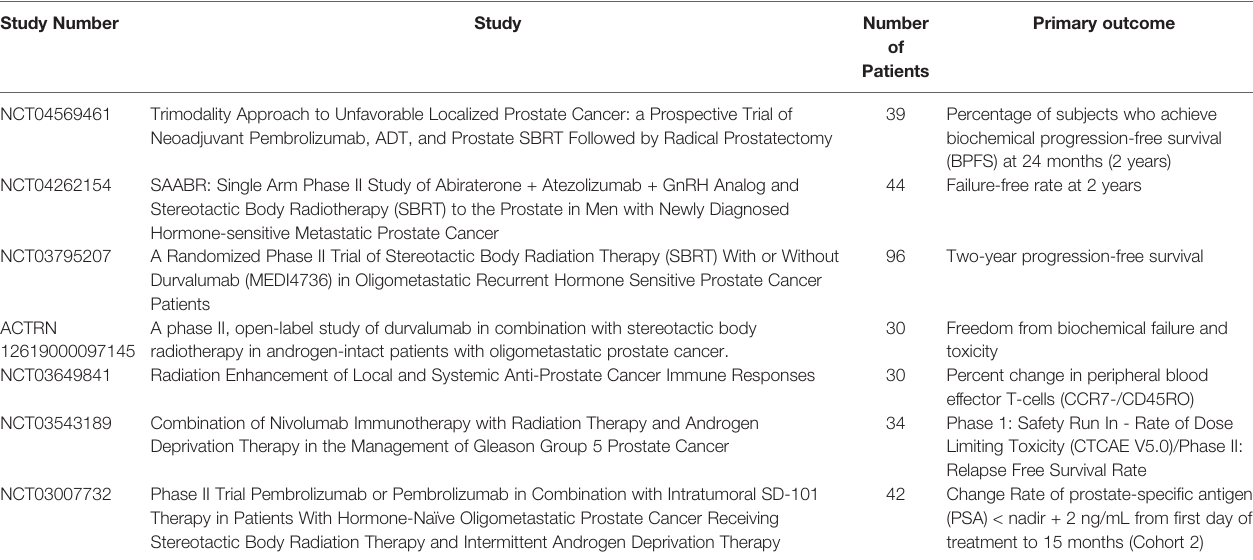
TABLE 3 | Ongoing radiation therapy and immunotherapy in prostate